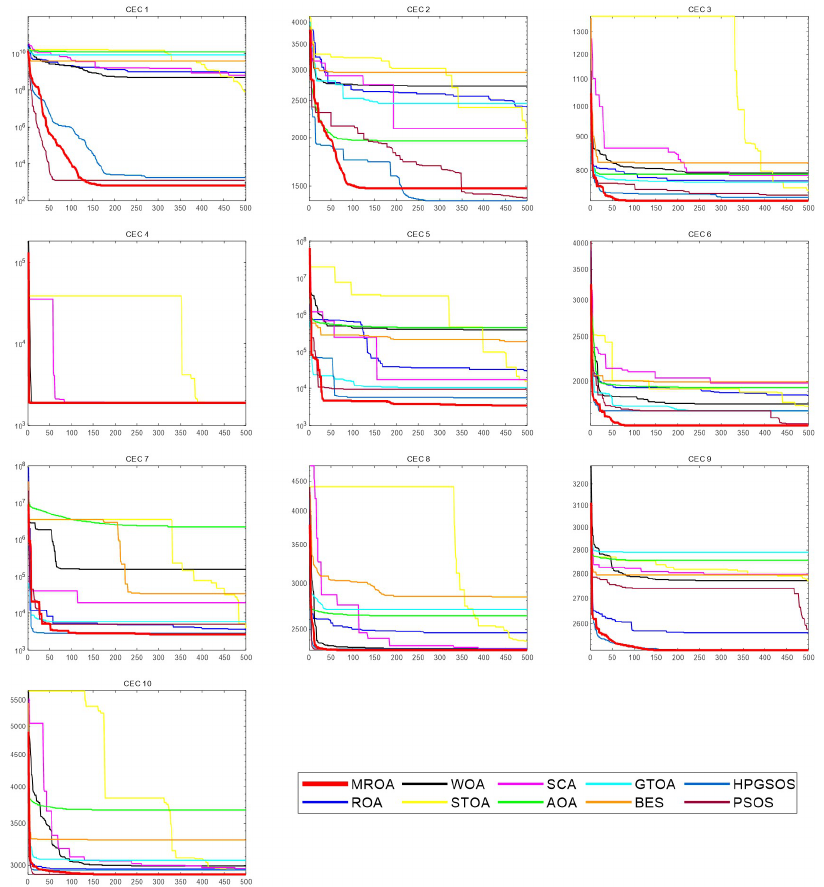
Figure 10. The convergence curves for the optimization algorithms on test functions (CEC 1–CEC